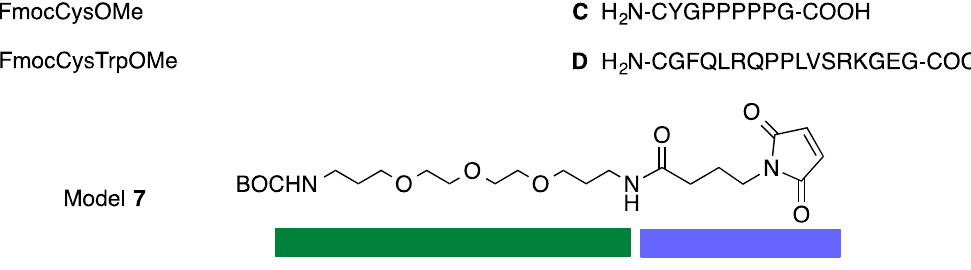
Figure 2. Thiols A – D in this study and model system 7 which models the dendritic domain ( green ) and functional domain ( blue